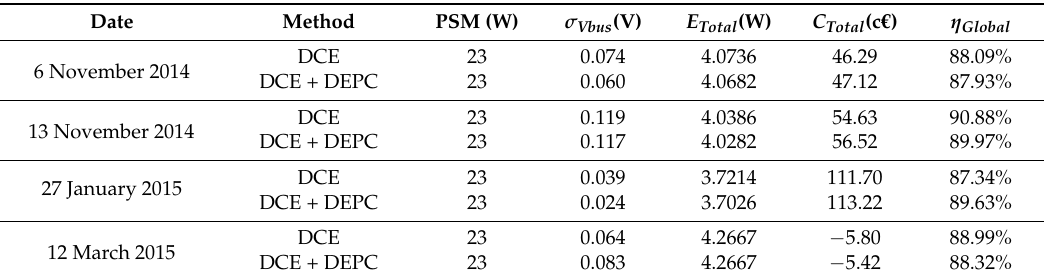
Table 4. Comparison of the three methods for the four considered days.